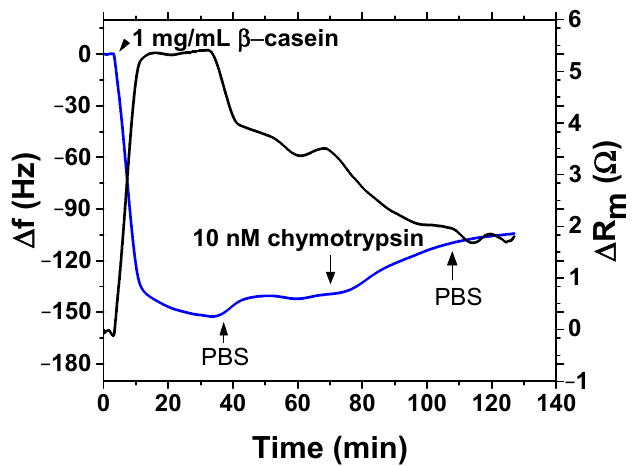
Figure 10. Kinetics of the changes of resonant frequency, f (blue), and motional resistance, R m (black), following modification of piezocrystal by β -casein and addition of 10 nM of chymotrypsin. Addition of various compounds as well as washing of the surface by PBS is shown by arrows.